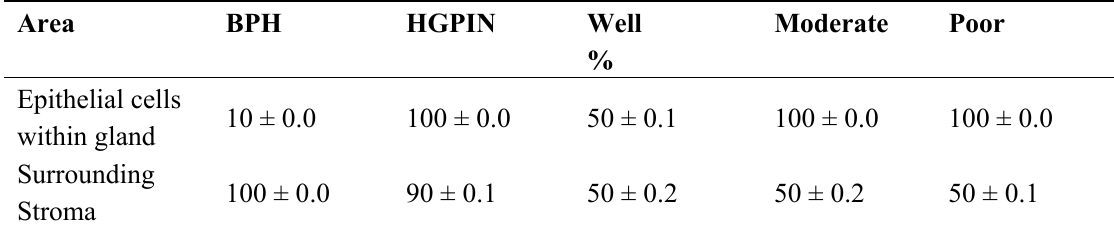
Table 2. Results of immunohistochemical studies for ATIP expression in paraffin-embedded human prostate sections expressed as percentage of tissues positive for ATIP staining. Area BPH HGPIN Well Moderate Poor % Epithelial cells 10 ± 0.0 100 ± 0.0 50 ± 0.1 100 ± 0.0 100 ± 0.0 within gland Surrounding 100 ± 0.0 90 ± 0.1 50 ± 0.2 50 ± 0.2 50 ± Stroma